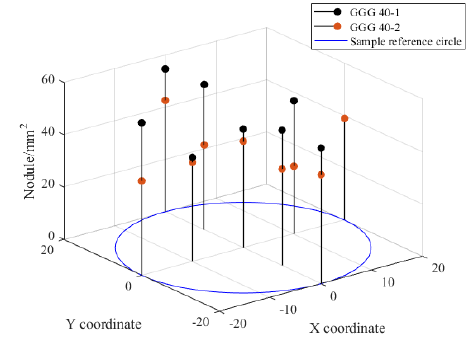
Figure 9. Nodule count in GGG40.